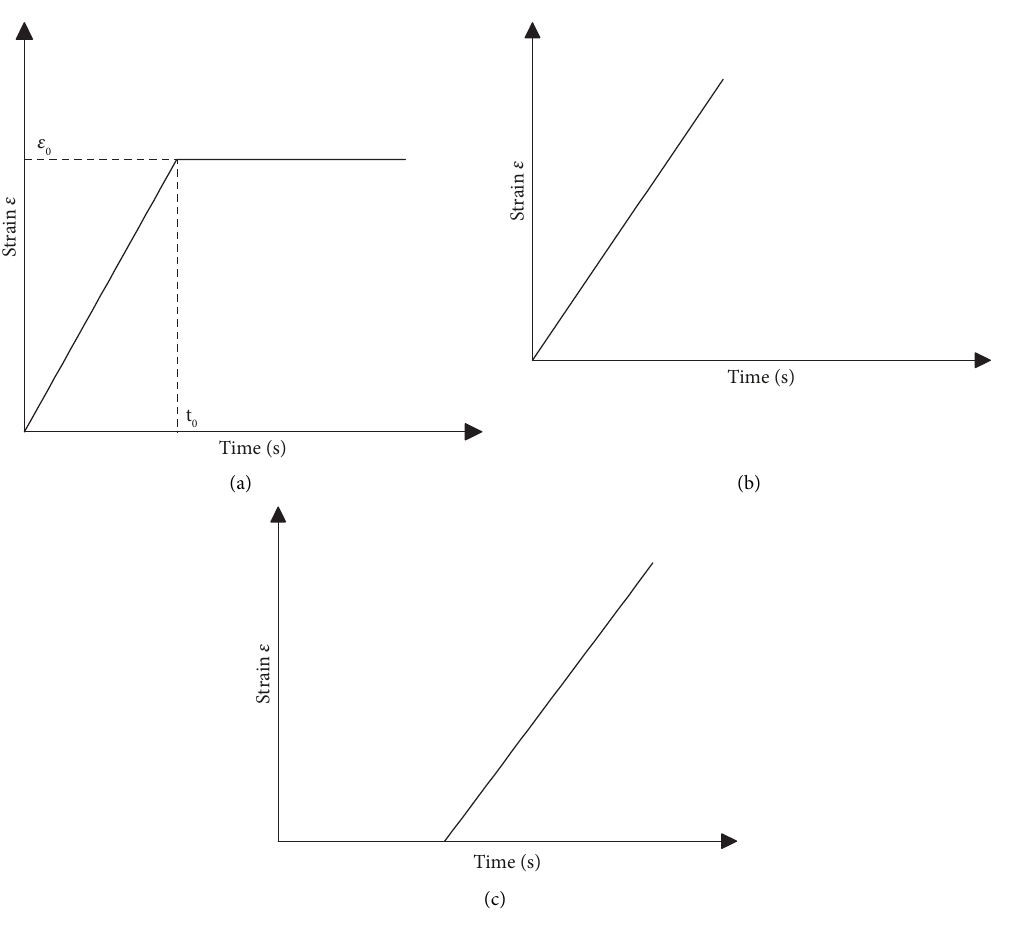
Figure 1: Ramp-constant strain history division ( a � b − c )